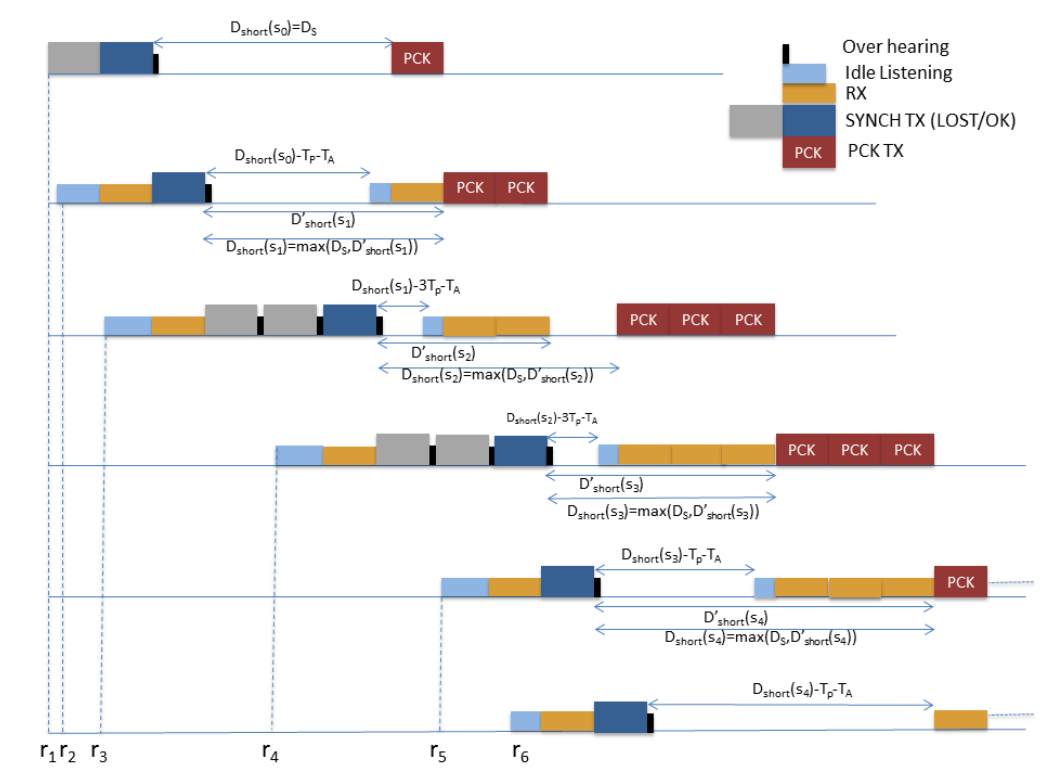
Figure 7. Illustrative example: flow of the DATA packets for the first 6 nodes (the synchronization phase is the same of Figure